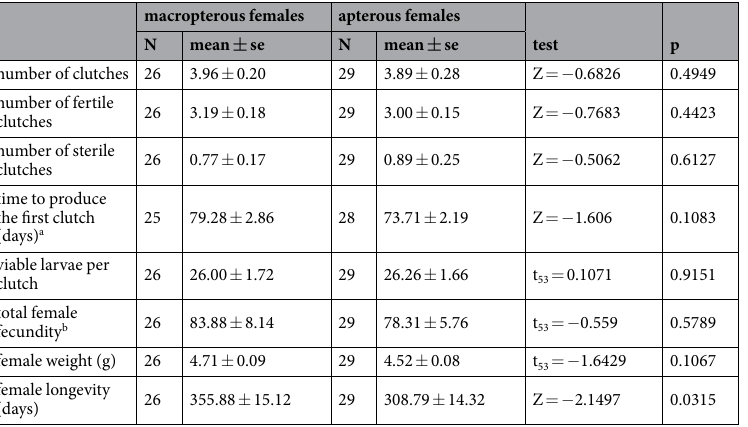
Table 1. Comparison of reproductive and condition parameters between macropterous and apterous females in Experiment 2: a Observation was excluded if the first produced clutch was sterile, while the second and following ones were fertile. b Number of larvae produced during the female’s